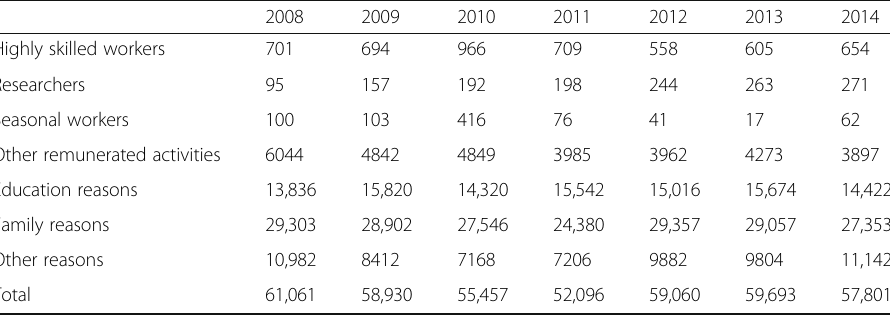
Table 1 Residence permits issued for Turkish citizens in